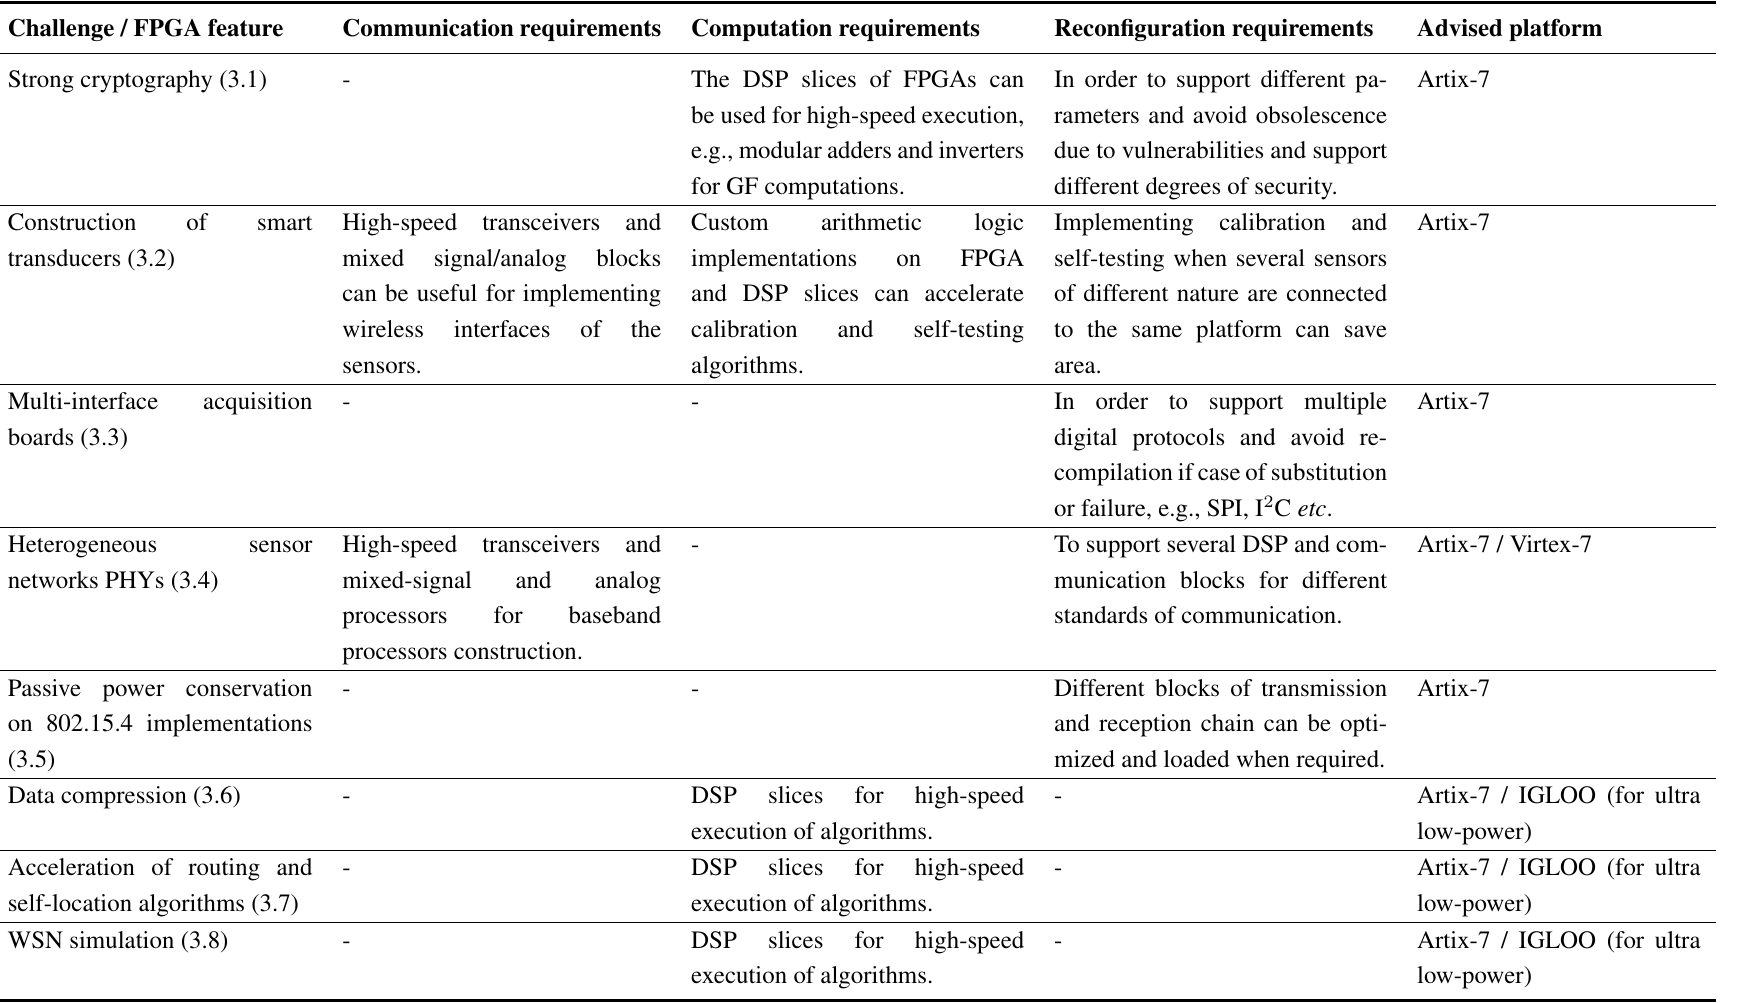
Table 5. Challenges on